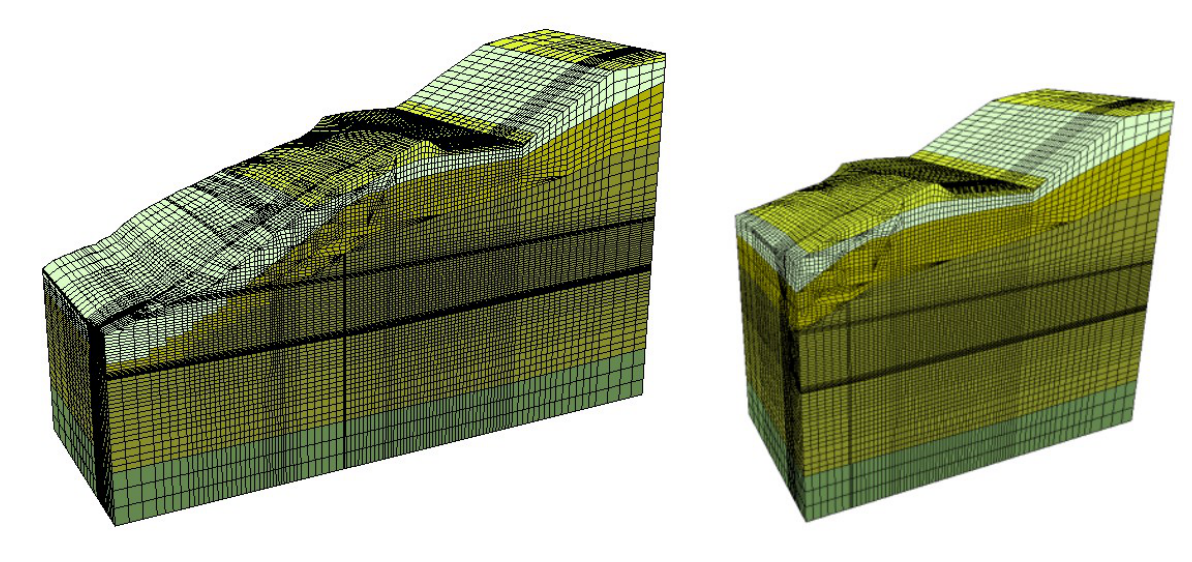
Figure 6. Large (left) and medium (right) size FEM model.